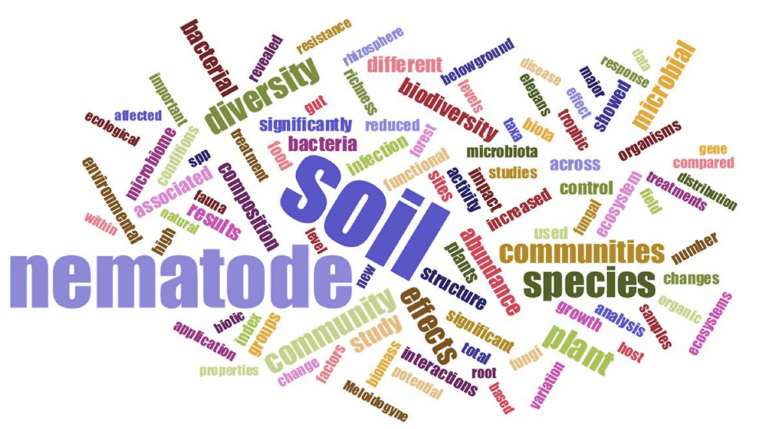
Figure 2. Most represented words in title and abstract of scientific papers with keywords “biodiver- sity”, “soil” and “nematode” in title and/or abstract, published during the last five years (source: PubMed, produced at https://www.jasondavies.com/wordcloud/ (accessed on 13 December